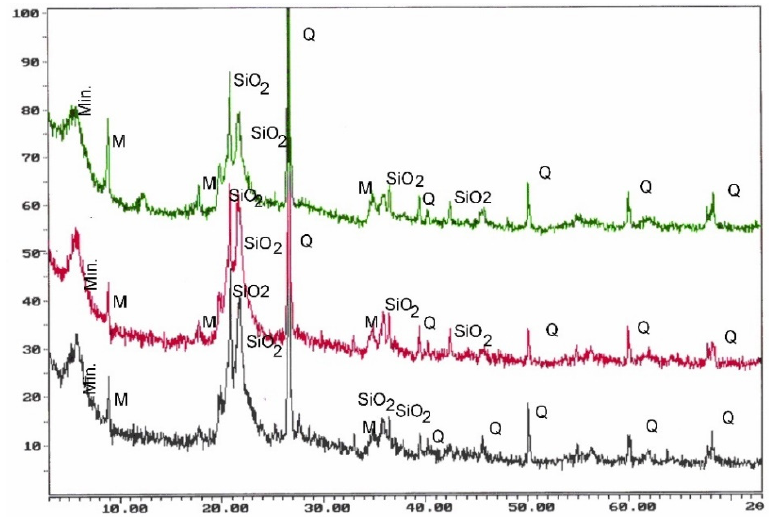
Figure 7. Examples of diffractometric curves. SiO 2 —silica phases in the form of opal (CT varieties relative to C), Q—quartz, M—mica, Min.—clayey minerals [67].